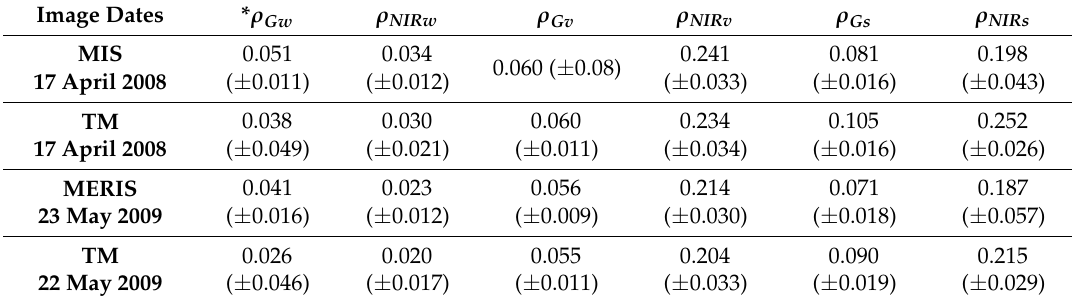
Table 2. Mean NIR and green spectral reflectance of the automatically selected water, vegetation and soil endmembers (standard deviations shown in